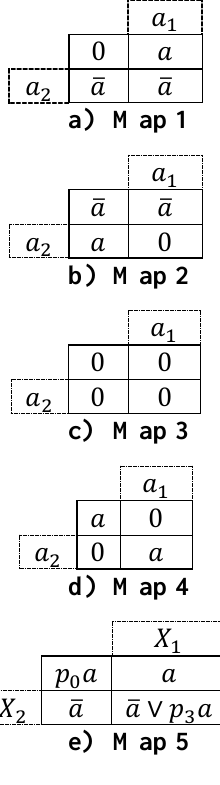
Figure 5. VEKMs for example